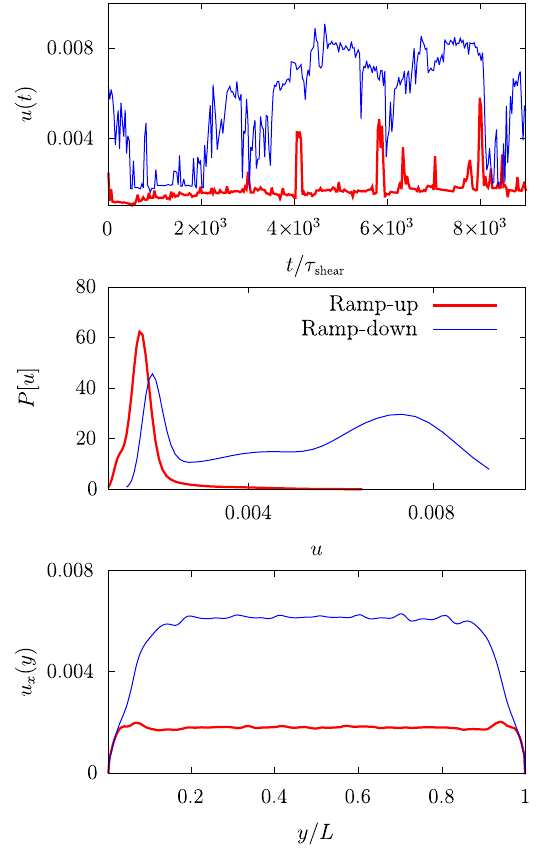
FIG. 11. Results for the flow driven by a constant pressure gradient producing a peak stress σ p = σ Y ≃ 1 . 4 . Different line thicknesses (indicated also with different colors) correspond to different system preparations: Data reported using the thick red line refer to a system previously driven from a lower forcing (i.e., ramp-up protocol), whereas data represented by a blue thin line refer to a system previously driven at a larger forcing (i.e., ramp- down protocol). Top panel: Velocity flux u ð t Þ as a function of time normalized by the shear time τ . The thick red line shear displays some intermittent spikes, while the blue one shows a sequence of transitions. Middle panel: Probability distributions for the velocity flux u displaying a single peak for the thick red line and a bimodal character for the thin blue line. Bottom panel: Velocity profile for u x ð y Þ averaged over time and along the streamwise direction x . The thick red curve indicates a plug-flow dynamics dominated by an elastic bulk, while the thin blue one shows a developed velocity gradient near the